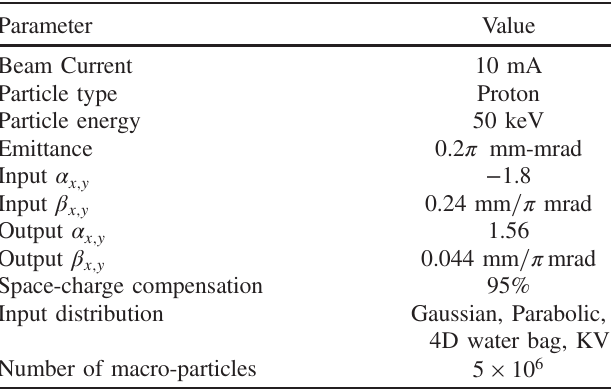
TABLE I. Input beam and space-charge compensation param- eters for the LEBT channel for a given acceptance of the